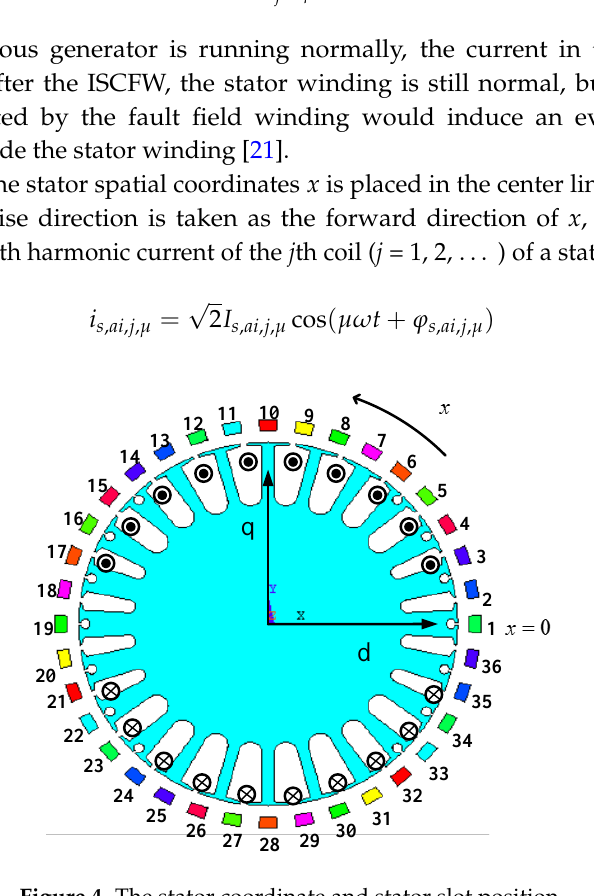
Figure 4. The stator coordinate and stator slot position.